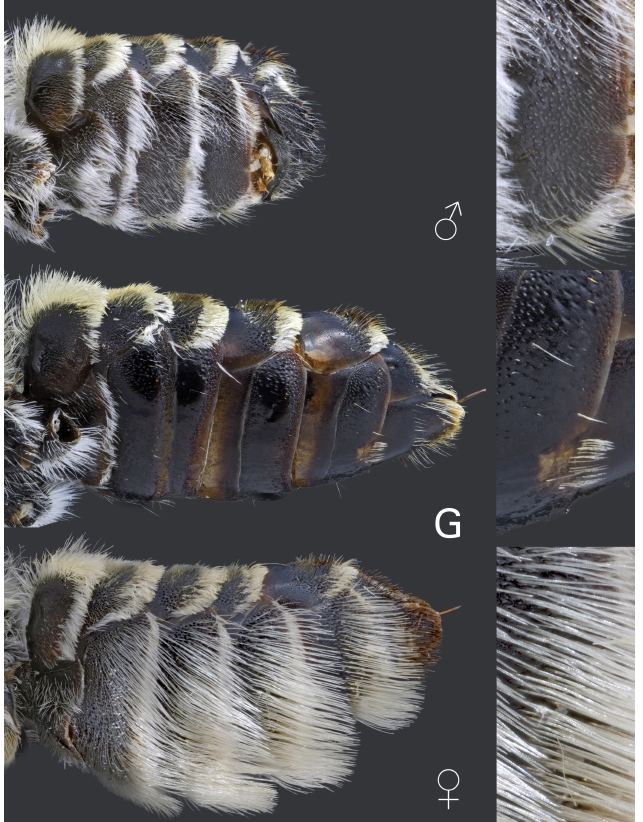
Figure 5. Metasoma of Megachile pilidens with detail of the penultimate sternite, ventro-lateral view: , male; G, gynandromorph; ♂